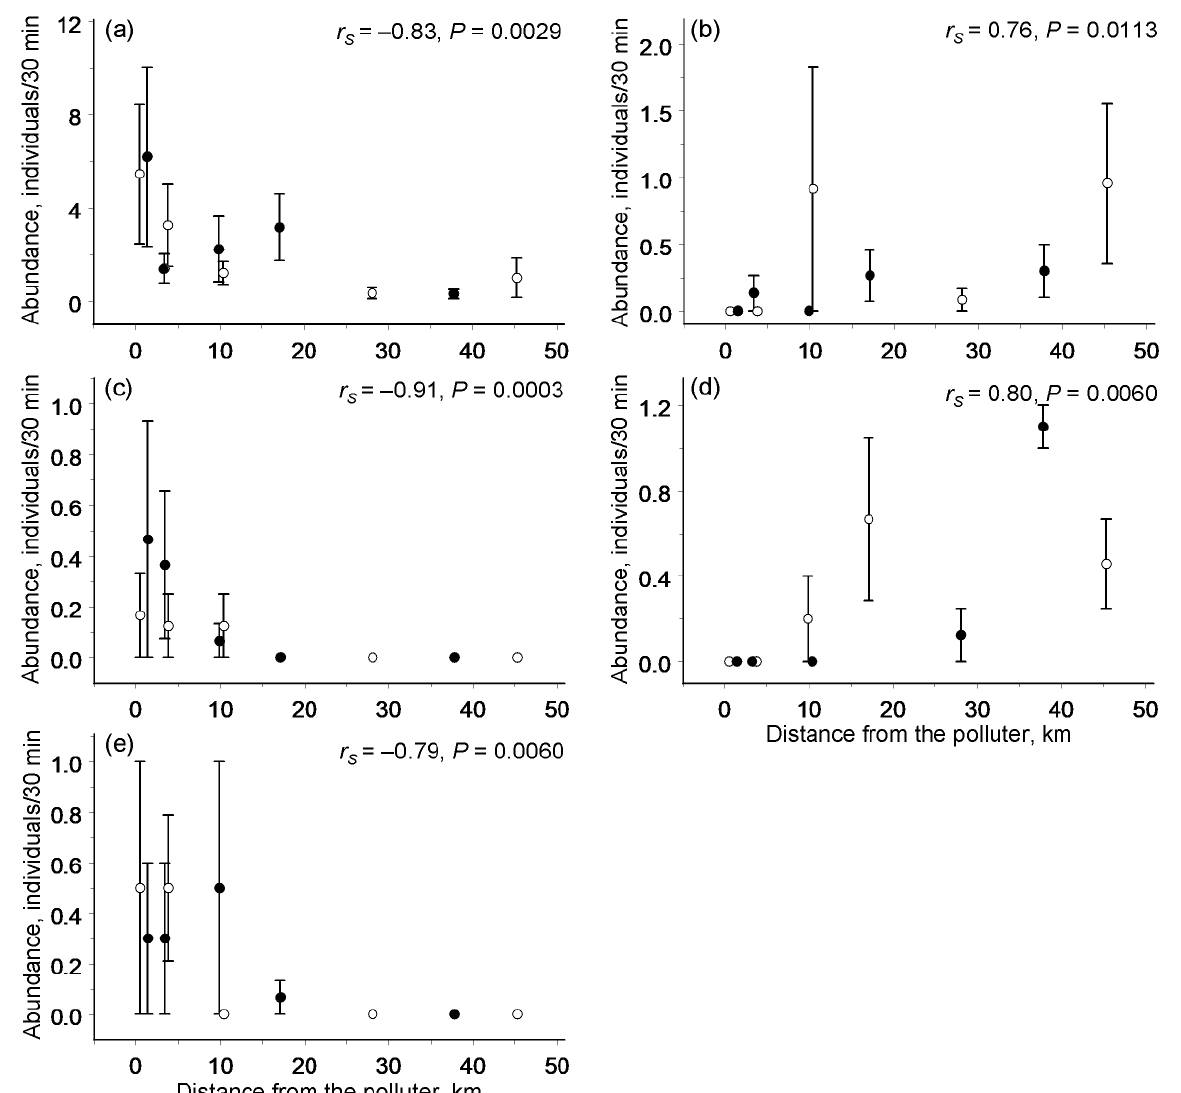
Figure 4. Significant changes in the abundance of individual species of moths and butterflies in relation to the distance from the Nikel copper–nickel smelter (filled circles) and from the Zapolyarnyy ore-roasting plant (empty circles): ( a ) Hedya atropunctana (Tortricidae), ( b ) Agriades optilete (Lycaenidae), ( c ) Gesneria centuriella (Crambidae), ( d ) Phiaris schulziana (Tortricidae), and ( e ) Plutella xylostella (Plutellidae). Values are the means (± SE) based on year-specific values.